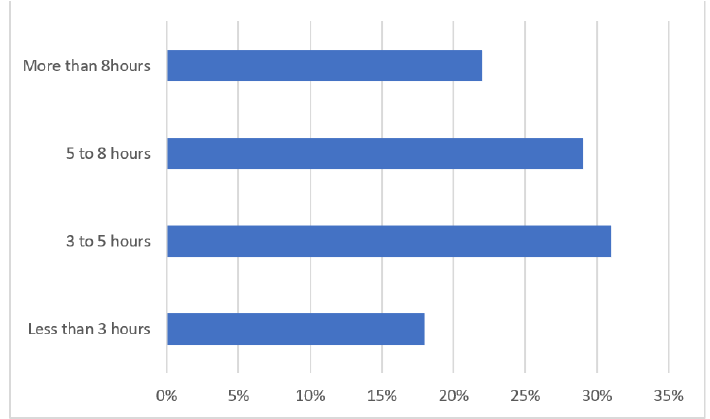
Figure 2. Working hours per day in 2018. Source: Survey by the authors.